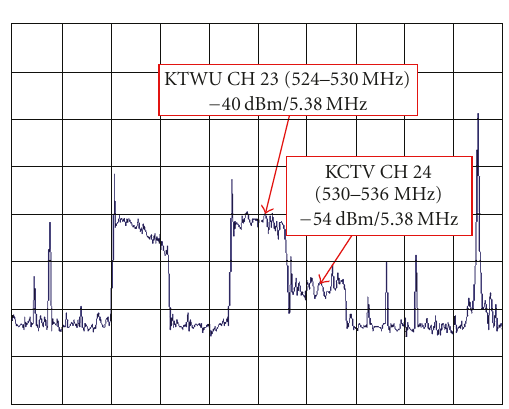
Figure 6: KTWU and KCTV Adjacent channel broadcasts.